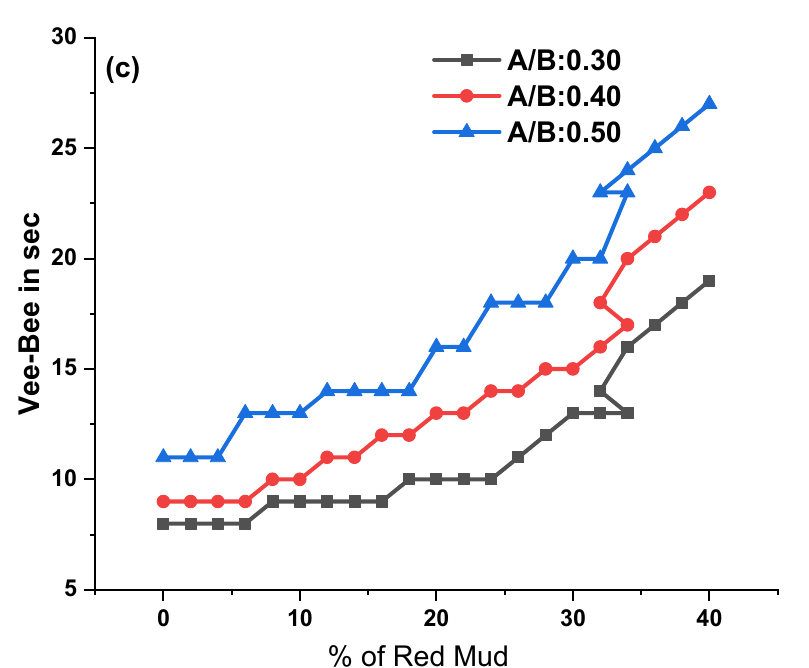
Figure 5. ( a – c ) These represent the slump, compaction, and vee-bee time results for A/B ratios of 0.3, 0.4, and 0.5 for various mixes of GPC, respectively.